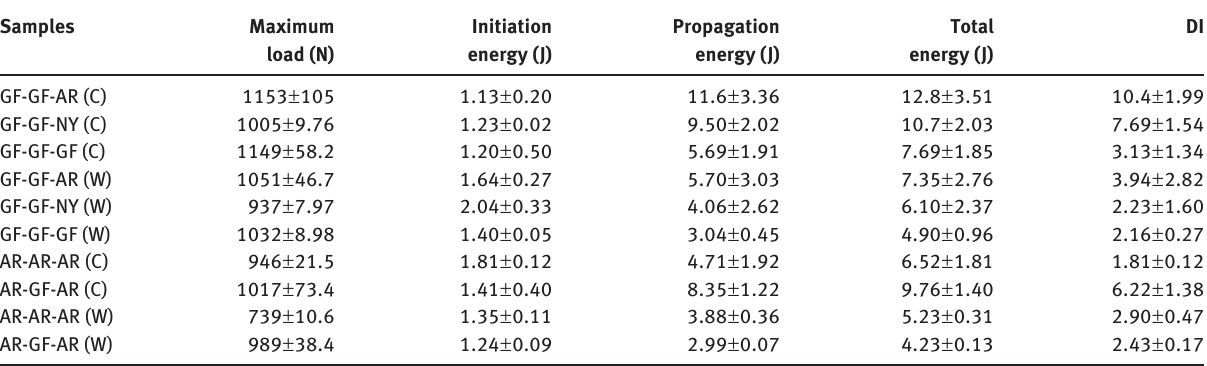
Table 2 Three-point bending impact test results of BWK composites in the course (C) and wale (W) directions: effect of stitch and biaxial yarns.